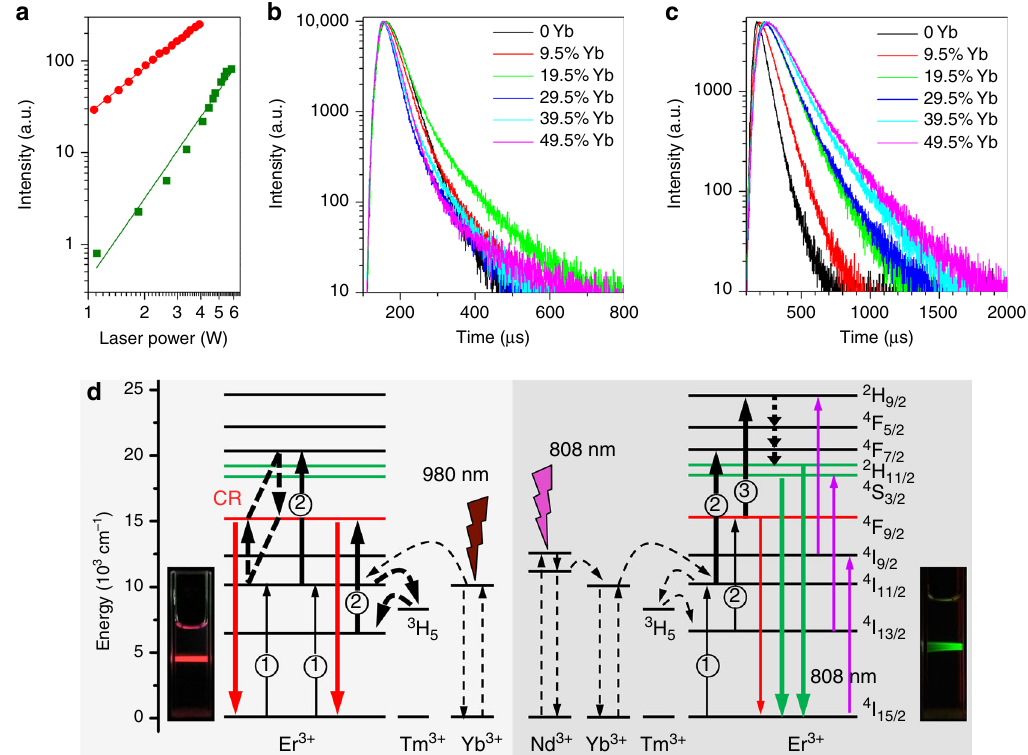
Fig. 2 Luminescence properties of UCNPs after excitation with 980/808 nm lasers. a Log-log plots of the 650 nm (red line) and 540 nm (green line) luminescence intensities for the Tm 3 + doped UCNPs under 980 nm and 808 nm excitations, respectively. b Luminescence decay curves of Er 3 + ions measured at 650 nm ( 4 F 9/2 → 4 I 15/2 ) for the nanocrystals with different doping amounts of Yb 3 + in the core upon excitation with 980 nm lasers. c Luminescence decay curves of Er 3 + ions measured at 540 nm ( 4 S 3/2 → 4 I 15/2 ) for the nanocrystals with different doping amounts of Yb 3 + in the core upon excitation with 808 nm lasers. d Two-photon upconversion mechanism for red emission under 980 nm laser excitation (left panel), and three-photon upconversion process for green emission under 808 nm laser excitation (right